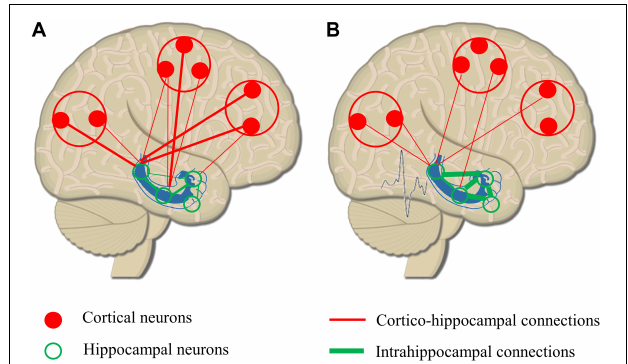
FIGURE 2 | Remodeling or hippocampo-cortical circuitry as a result of epileptic discharges. (A) Physiological organization of hippocampo-cortical connections with numerous, strong local connections and less and weaker distant associations. (B) As a result of epileptic discharges, intrahippocampal connectivity is increased, and the strength and number of long distant connections are decreased. The remodeling of network circuitry leads to a relative isolation of hippocampus from cortical areas reducing the efficacy of hippocampo-cortical